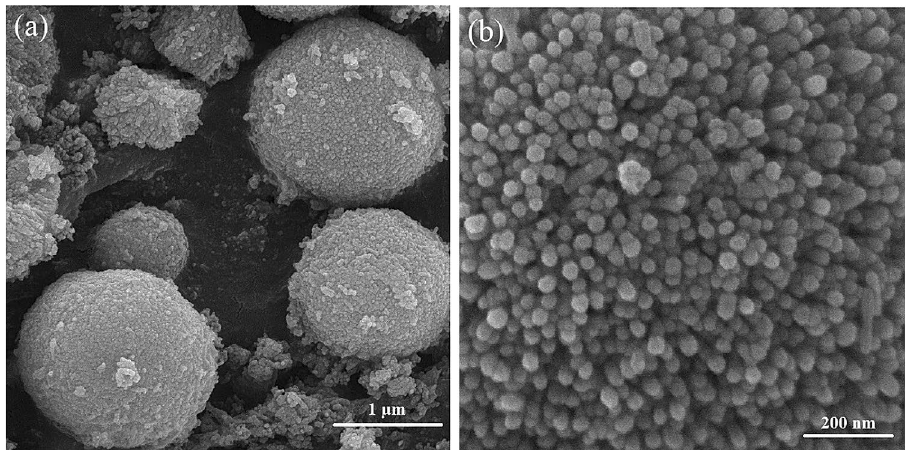
Figure 2. Field emission scanning electron microscopy (FESEM) images of the ZnO microspheres: ( a ) at scale bar 1 μm and ( b ) 200 nm from the surface of a microsphere.